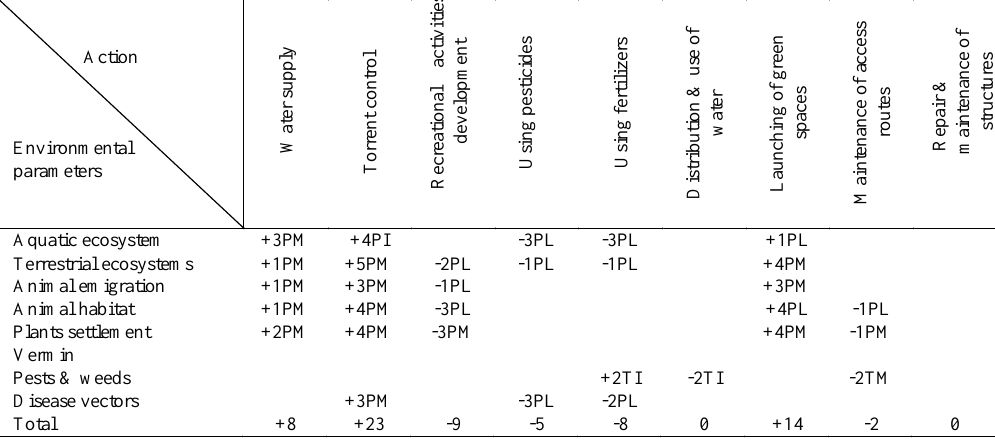
Table 7: Prediction matrix of ecological impact s of irrigation and drainage network in operation